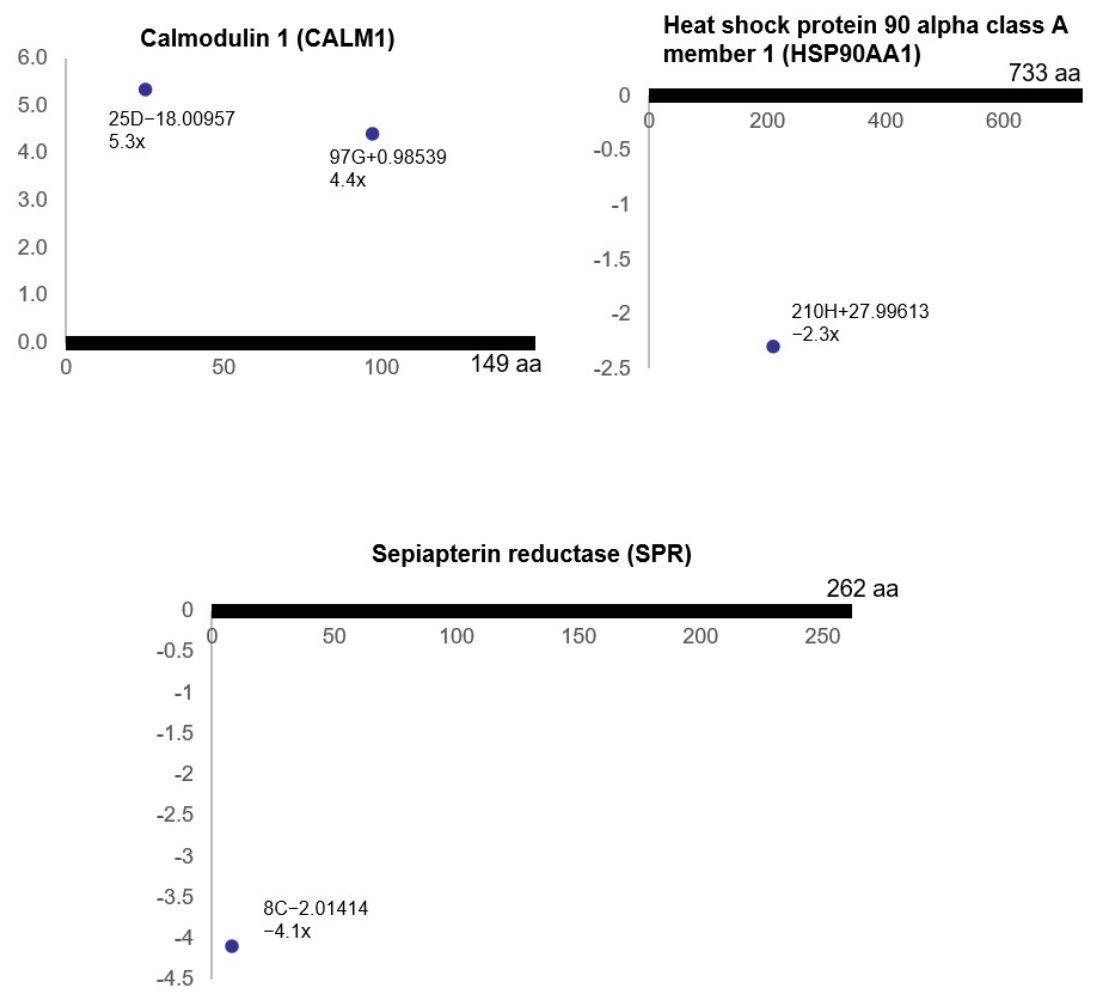
Figure 3. The modified residues of the proteins involved in tetrahydrobiopterin (BH4) synthesis, recycling, salvage and regulation (R 2 > 0.5, ratio > 2, p < 0.05). Each dot represents ncAA of each protein. The annotation information of each dot is as follows: modified (protein) position, modified amino acid residue, delta mass and ratio of modification. The horizontal axis represents the amino acid position of each protein; the vertical axis represents the ratio of modification (up or down). The possible modification for each nonzero delta mass is as follows: − 18.00957: E > pyro-E, dehydration; 0.98539: deamidation, N > D, Q > E; 27.99613: formylation, S > D, T > E; − 2.01414: disulfidelation, V > P, − 2H(didehydro).